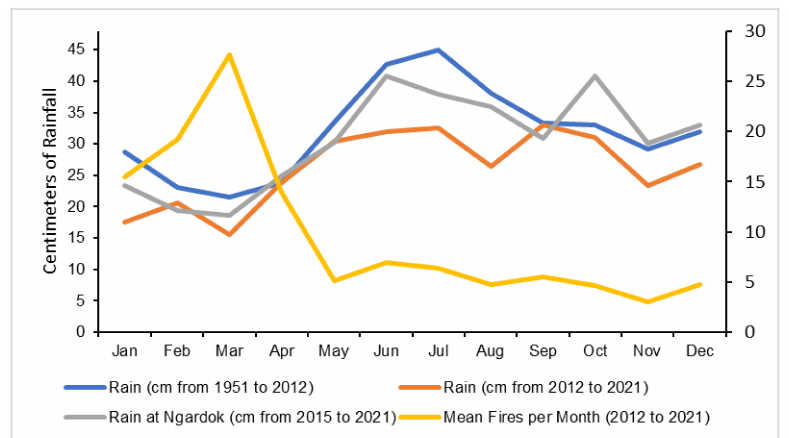
Figure 4. Mean monthly wildfires and rainfall (cm) on Babeldaob Island, Palau, showing fires that could be assigned a fire date to the nearest month, rainfall at the meteorological station on Koror Island for the available historical period before and during the study (data from 2013 were removed due to incompleteness), and rainfall for 2015–2021 at the meteorological station at Lake Ngardok Nature Reserve in central Babeldaob.